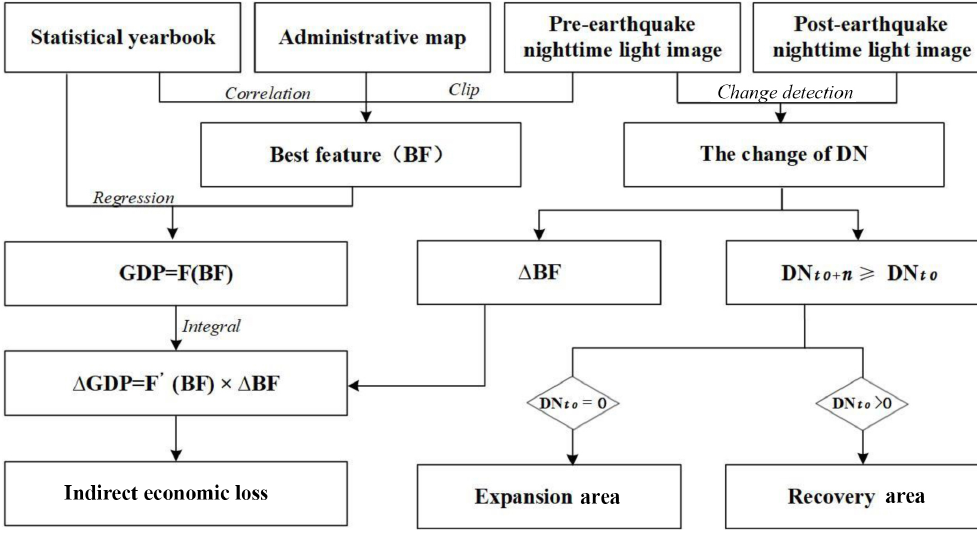
Figure 3. Technical